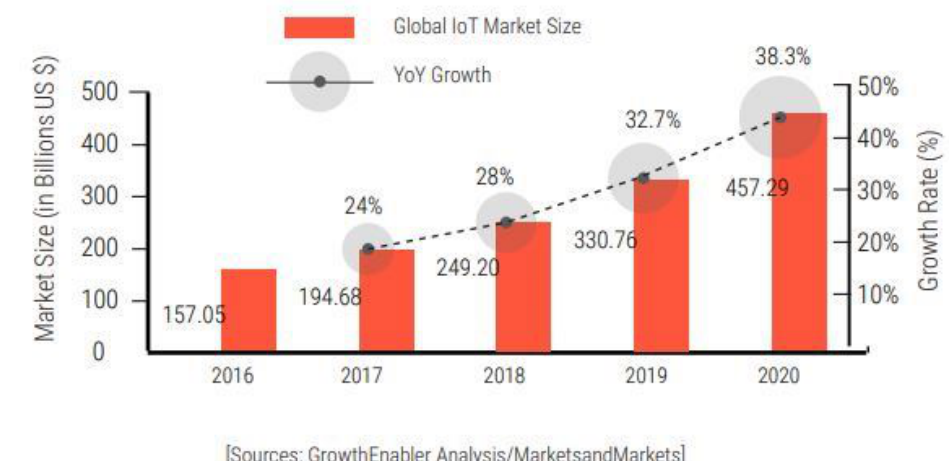
Figure 1. IoT market size and growth forecast